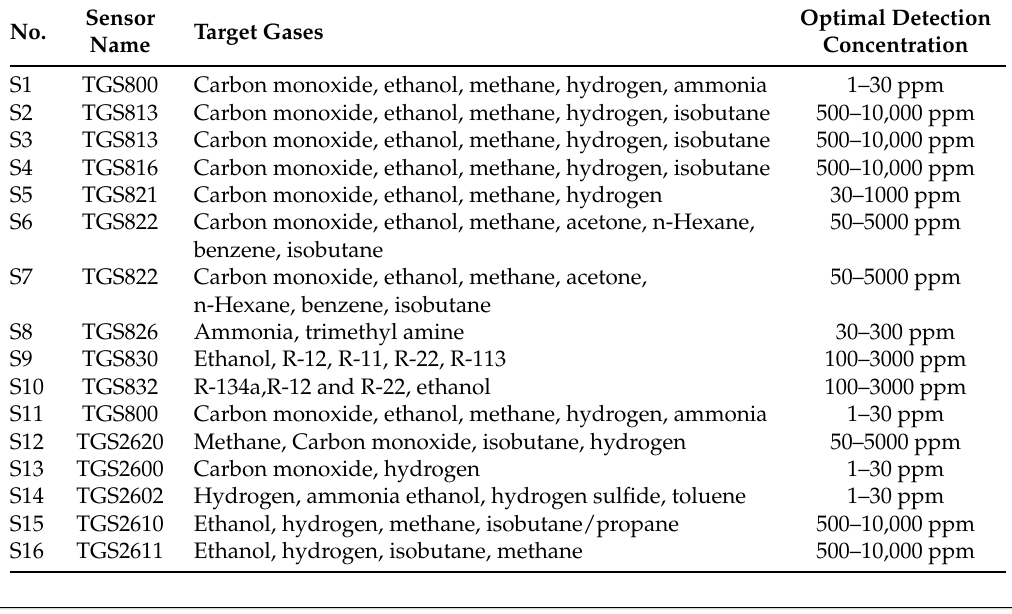
Table 2. The Target gases of sensors.